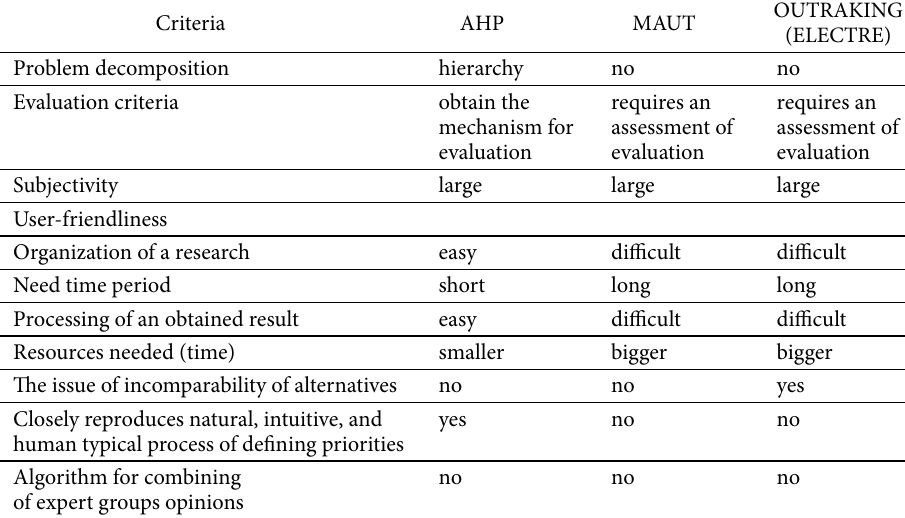
Algorithm for combining of expert groups